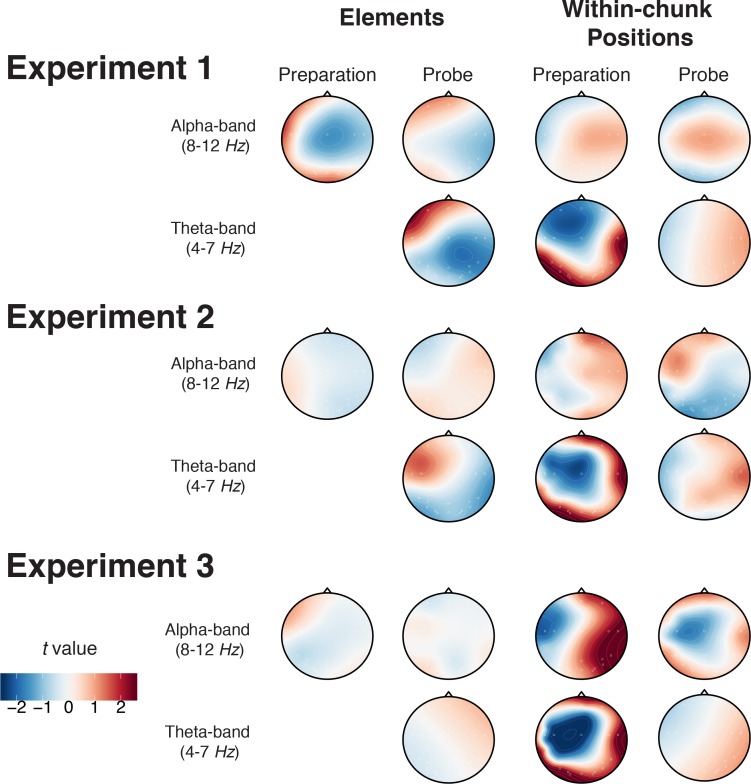
Topography of reconstructed activation patterns for element and within-chunk position codes across Experiment 1, 2 and 3.Significant t-values indicate that the EEG activity at the given electrode contributed to the decoding results consistently among individuals.